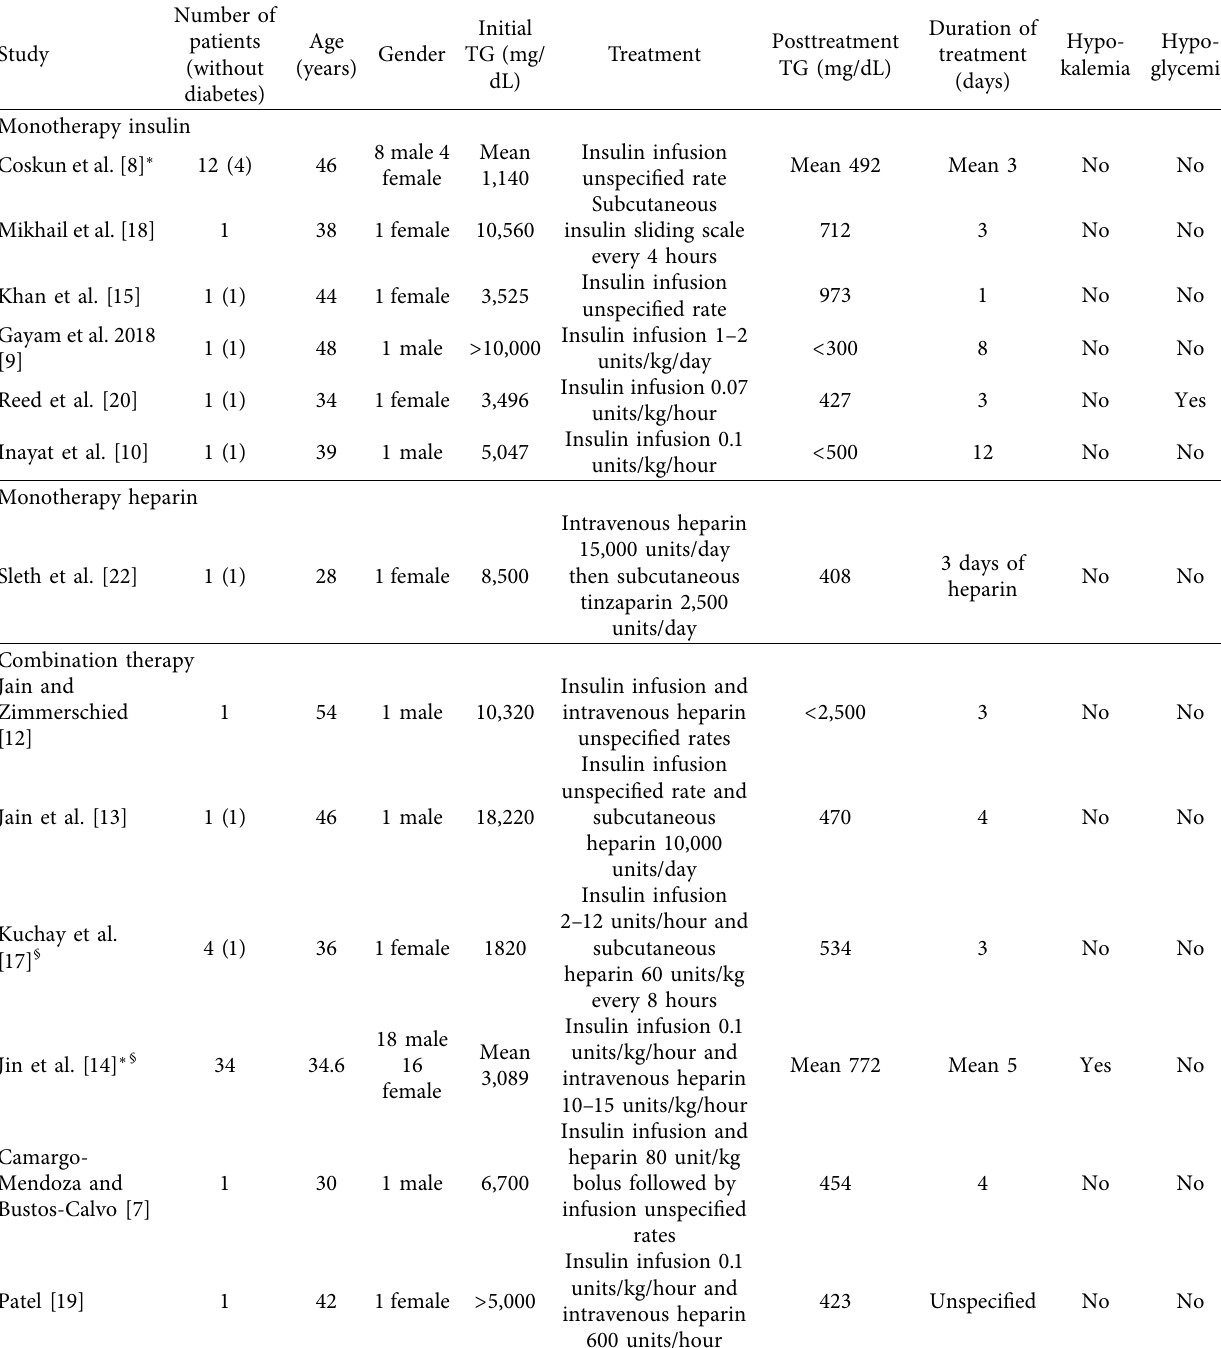
Table 1: Studies evaluating insulin and/or heparin for hypertriglyceridemia management in adult